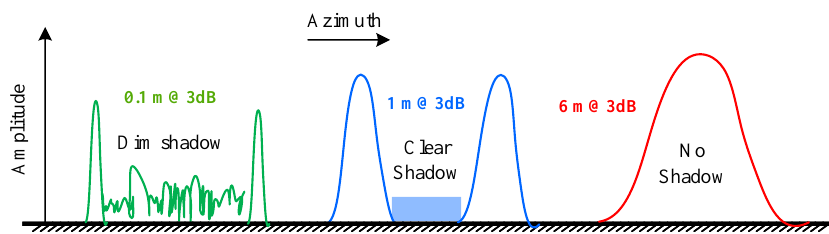
Figure 3. Schematic of different system resolutions. The red, blue and green lines in the figure represent resolution of 6, 1 and 0.1 m,